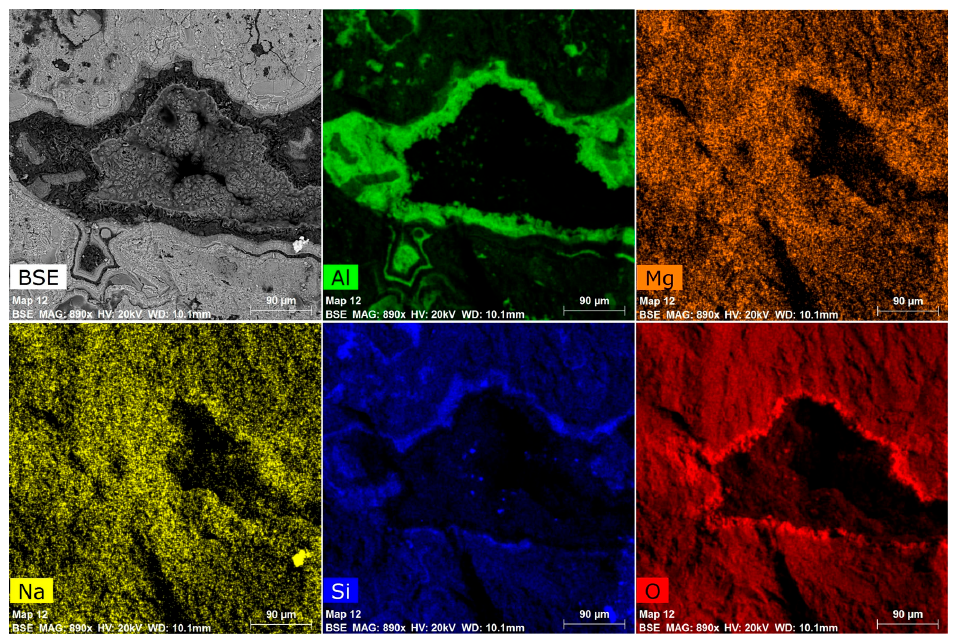
Figure 4. Elemental mapping shows that the Al-dominated minerals contain the major constituents of kaolinite. of kaolinite.